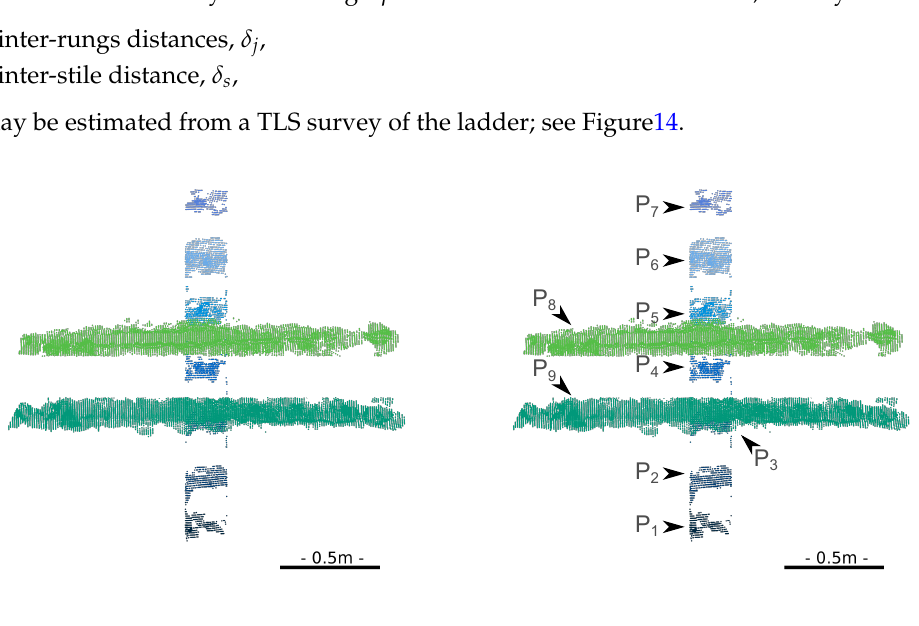
Figure 17. ( Left ) The 2D ladder point cloud is first split into two stile point clouds and seven rung point clouds; ( Right ) The stiles are rotated, and only one direction has to be adjusted on the